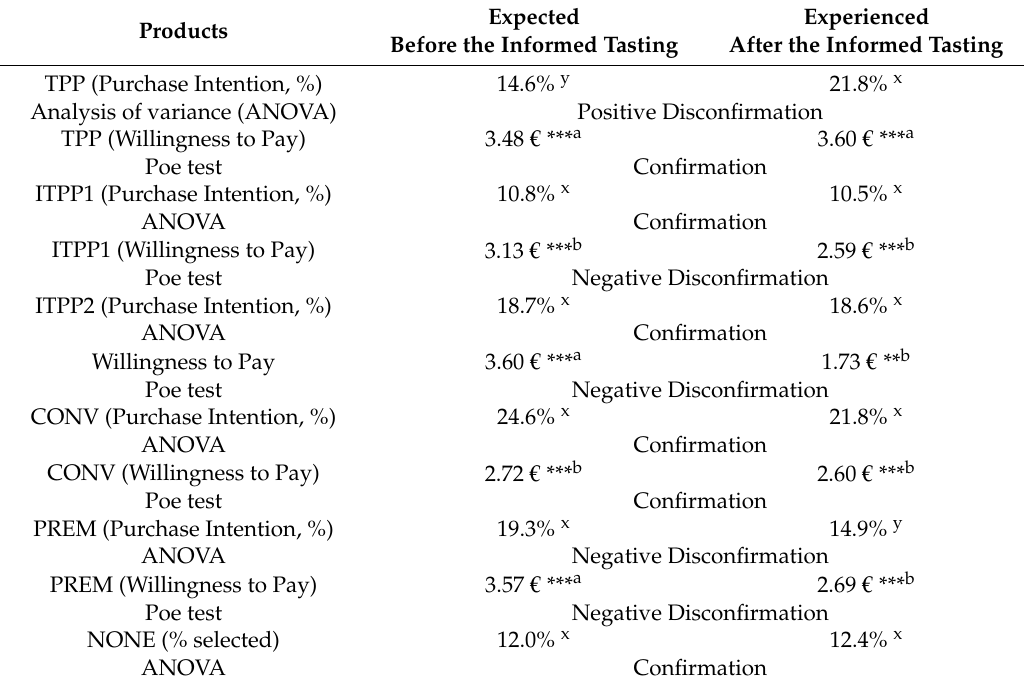
Table 4. Willingness to pay (WTP) and purchase intention (PI) before and after the hedonic evaluation